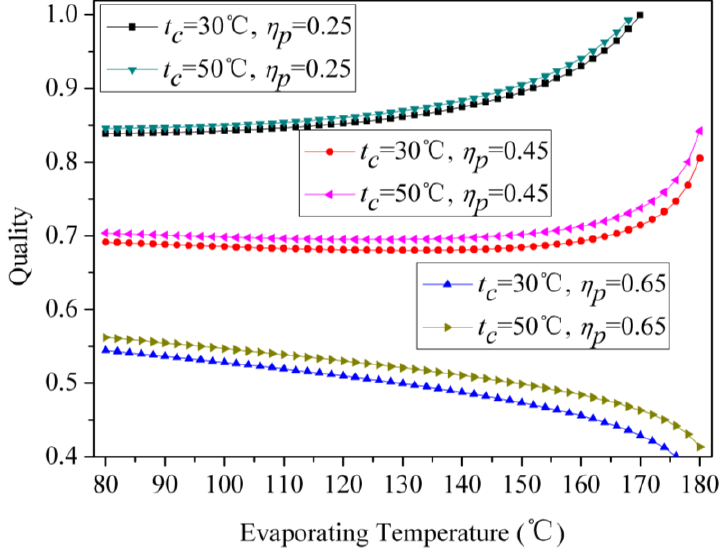
Figure 5. The minimum vapor quality required vs. evaporating temperature (R123).